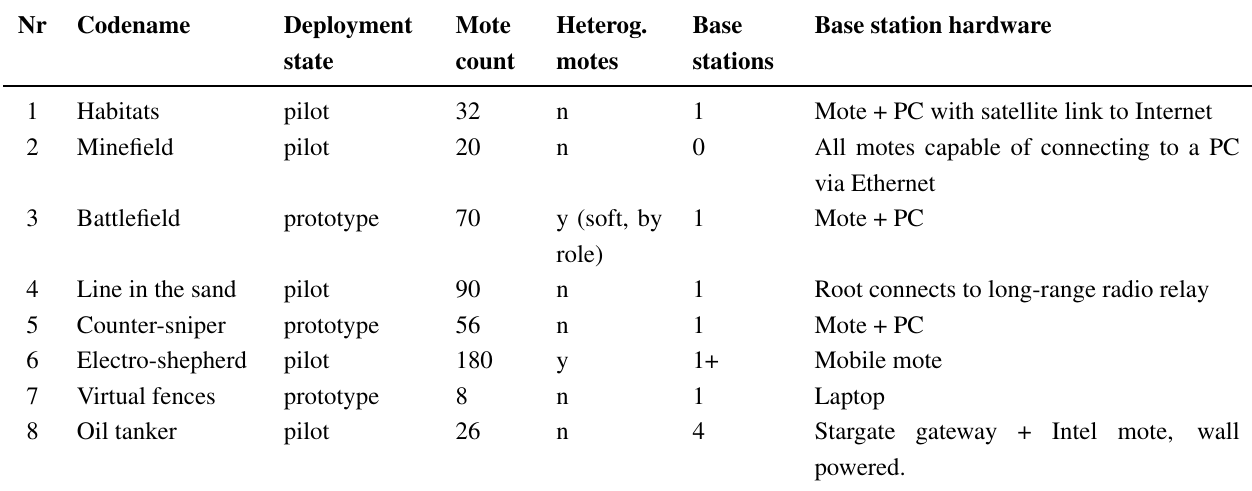
Table 2. Deployments: deployment state and